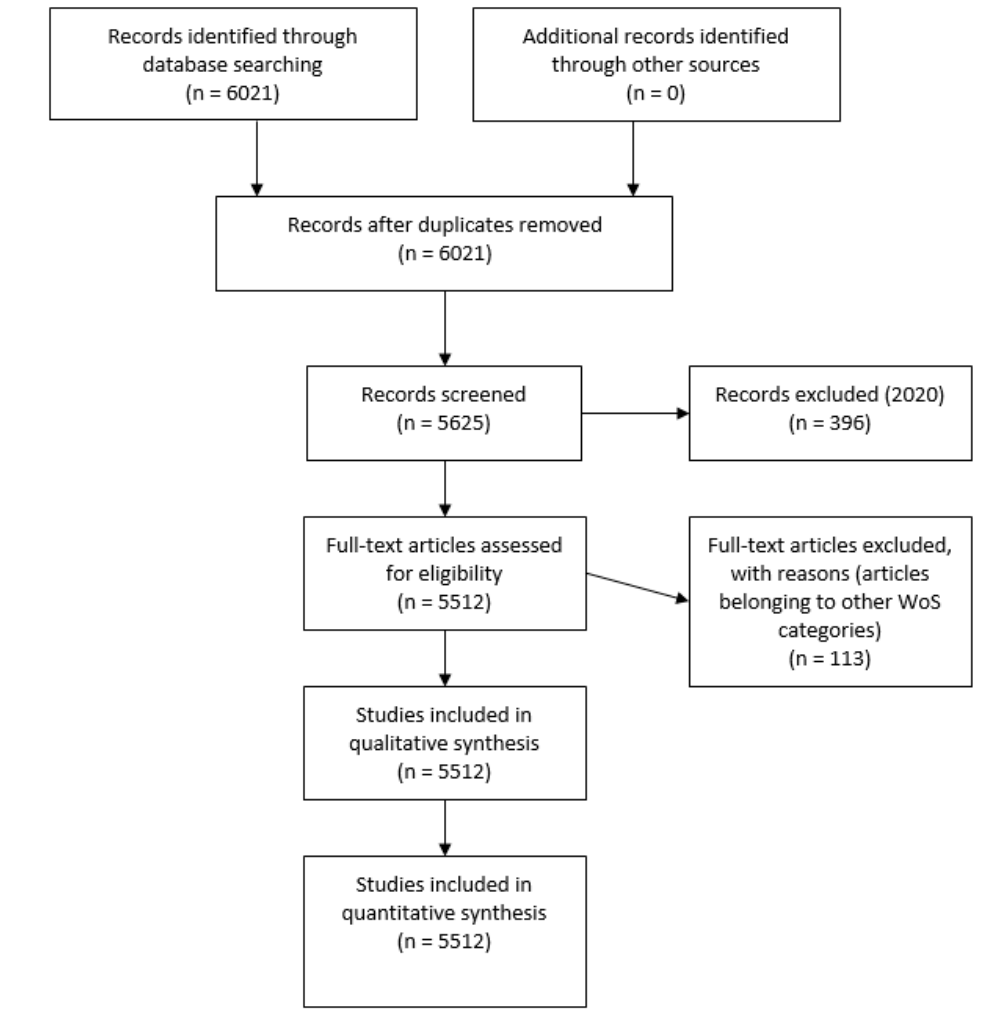
Figure 1. Flowchart according to the PRISMA Declaration.